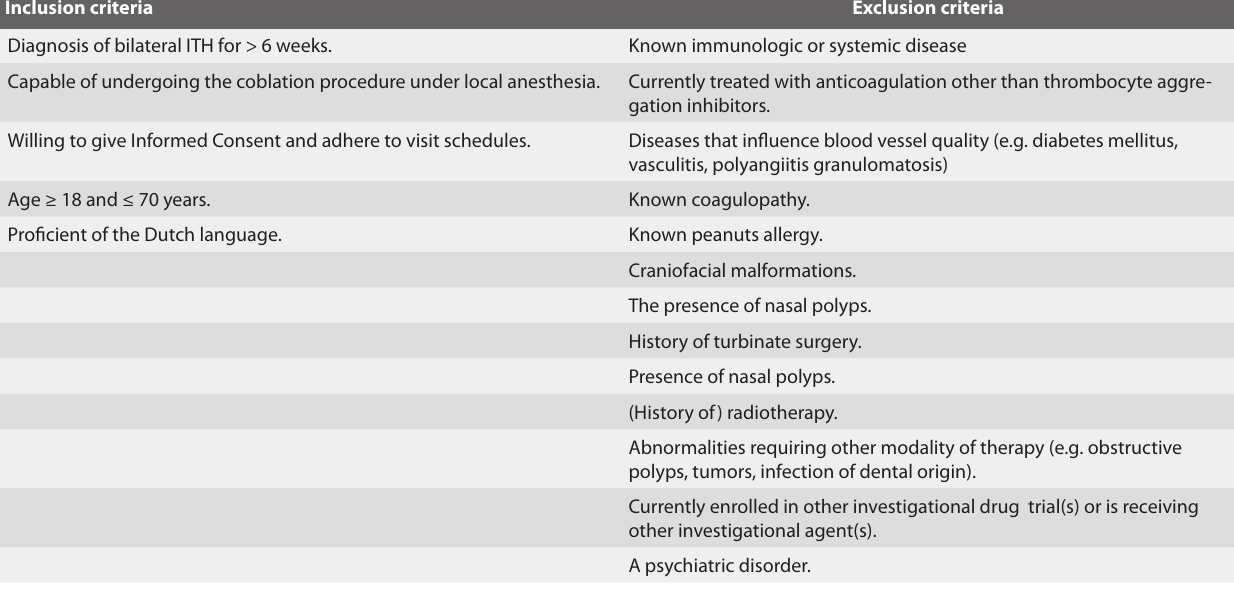
Table 1. inclusion and exclusion criteria. Inclusion